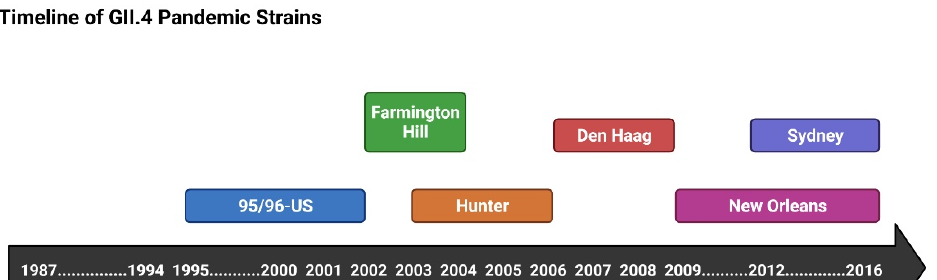
Figure 9. Timeline of GII.4 Pandemic Strains. The first GII.4 pandemic was reported in 1987 and was caused by the 95/96-US variant. Ever since, every 2–4 years a new variant emerged to take over. Since then, five more pandemic strains have emerged, and the Sydney (2012) variant has dominated ever since. Made using Biorender.com accessed on 18 October 2022 .